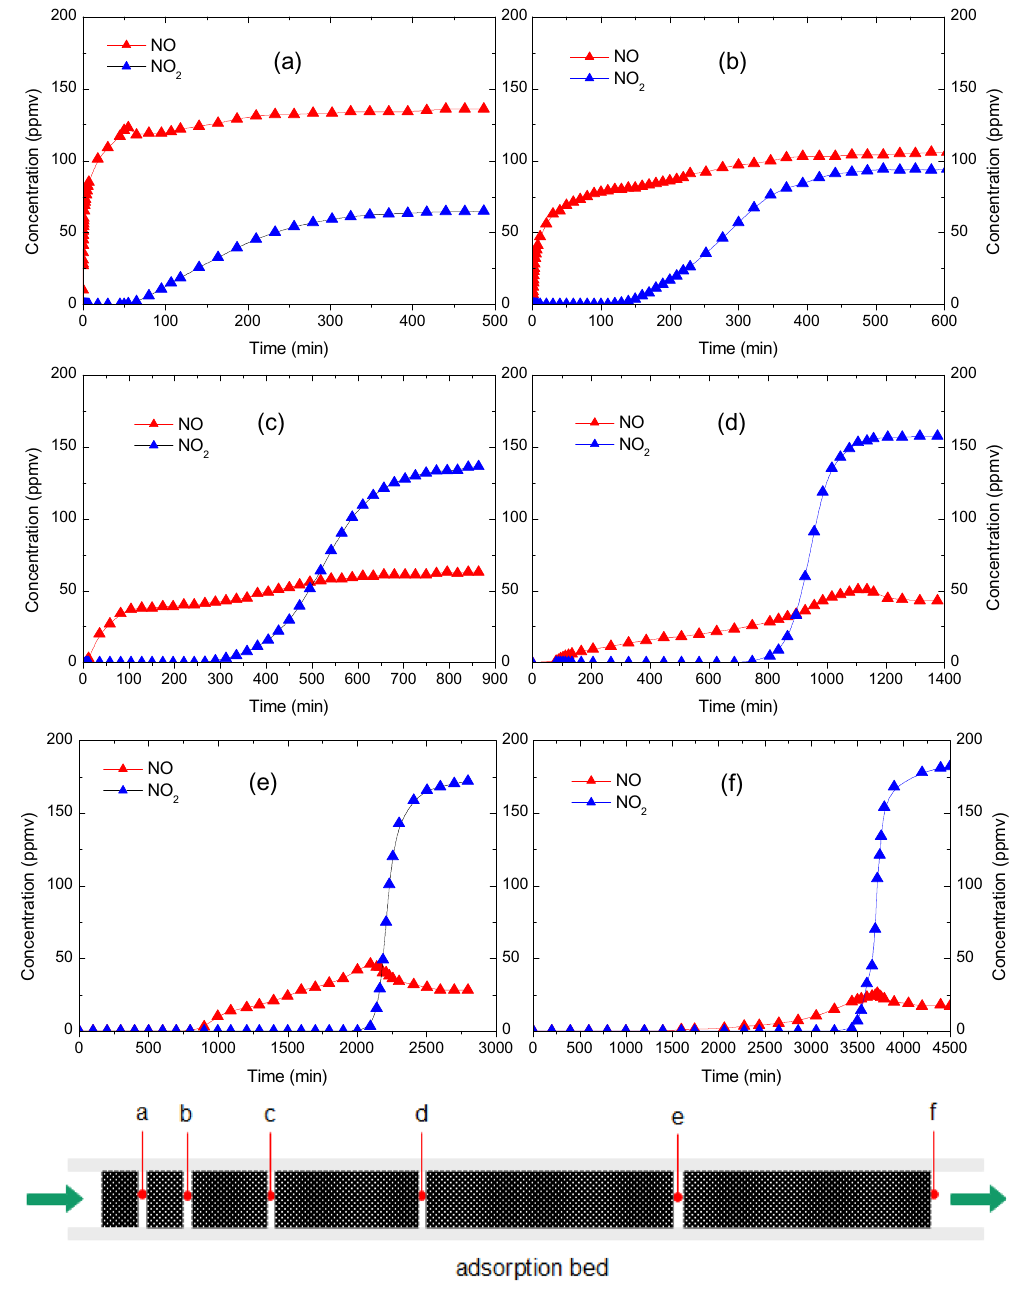
Figure 8. Breakthrough curves of NO (red) and NO 2 (blue) during NO–O 2 co-adsorption at various cross sections of adsorption bed: ( a ) 120,000 h −1 , ( b ) 60,000 h −1 , ( c ) 30,000 h −1 , ( d ) 15,000 h −1 , ( e ) 7500 h −1 and ( f ) 5,000 h −1 (NO = 200 ppmv, O 2 = 6 vol.%, T = − 0 ℃